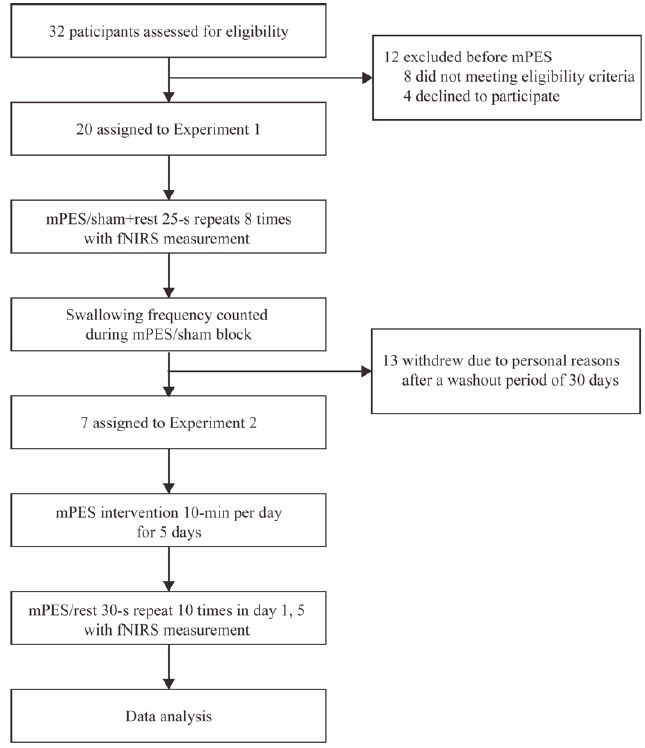
Figure 3. Flow diagram of the trial. mPES modified pharyngeal electrical stimulation; fNIRS functional near-infrared spectroscopy.